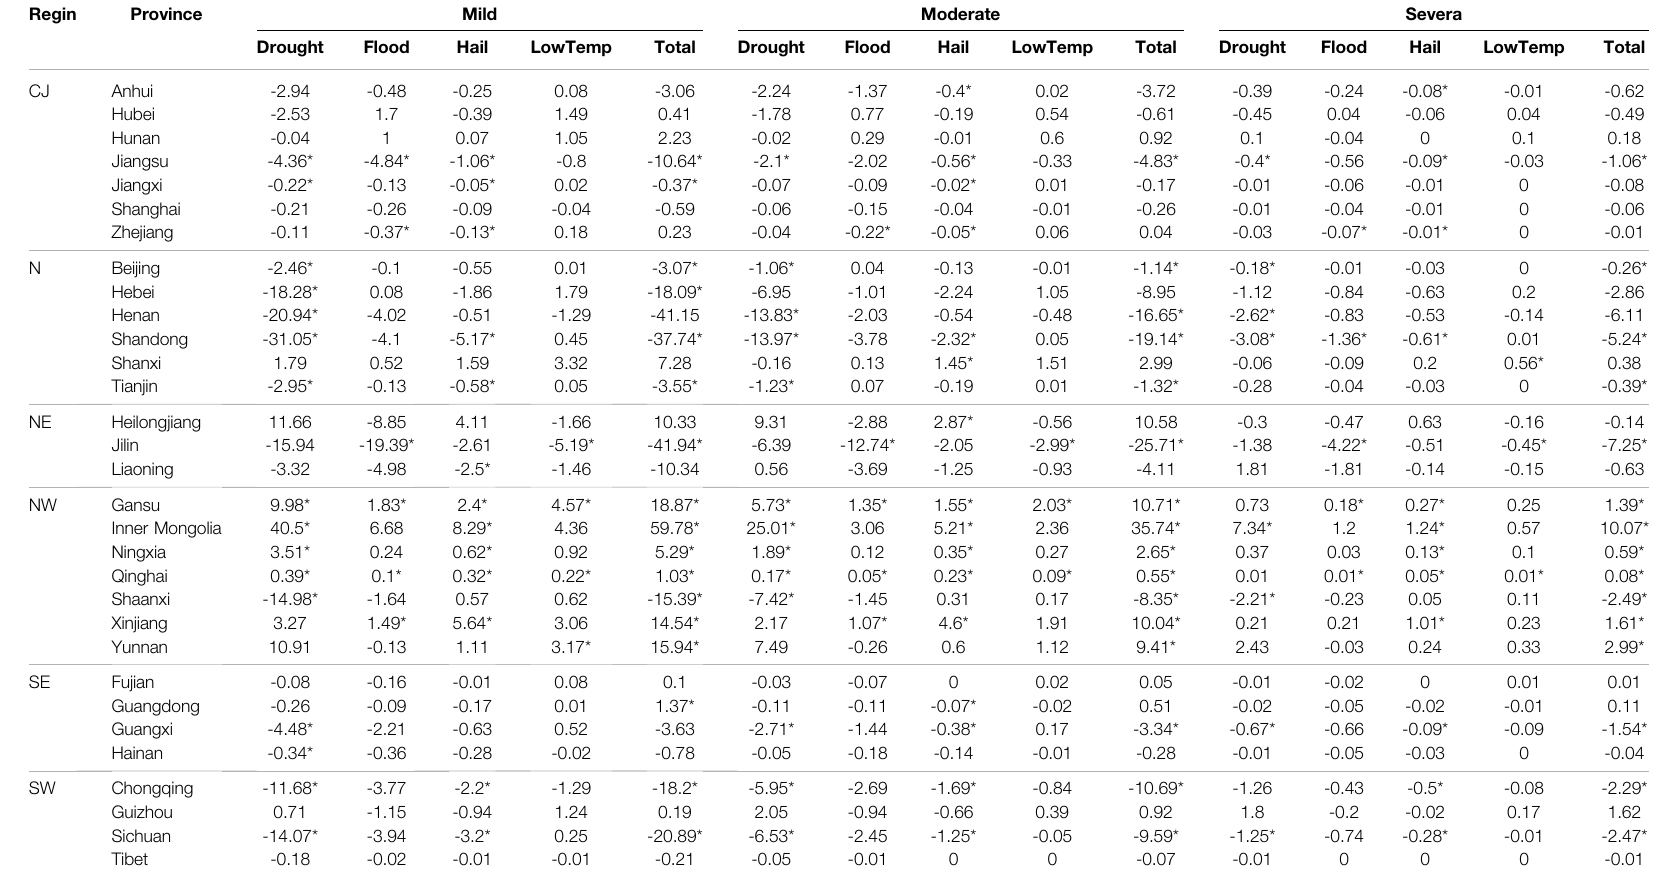
TABLE 1 | Linear changes in the maize cultivation area affected by different natural disasters from 1988 to 2020. * indicates the presence of statistical signi fi cance (Ps < 0.05). Regin Province